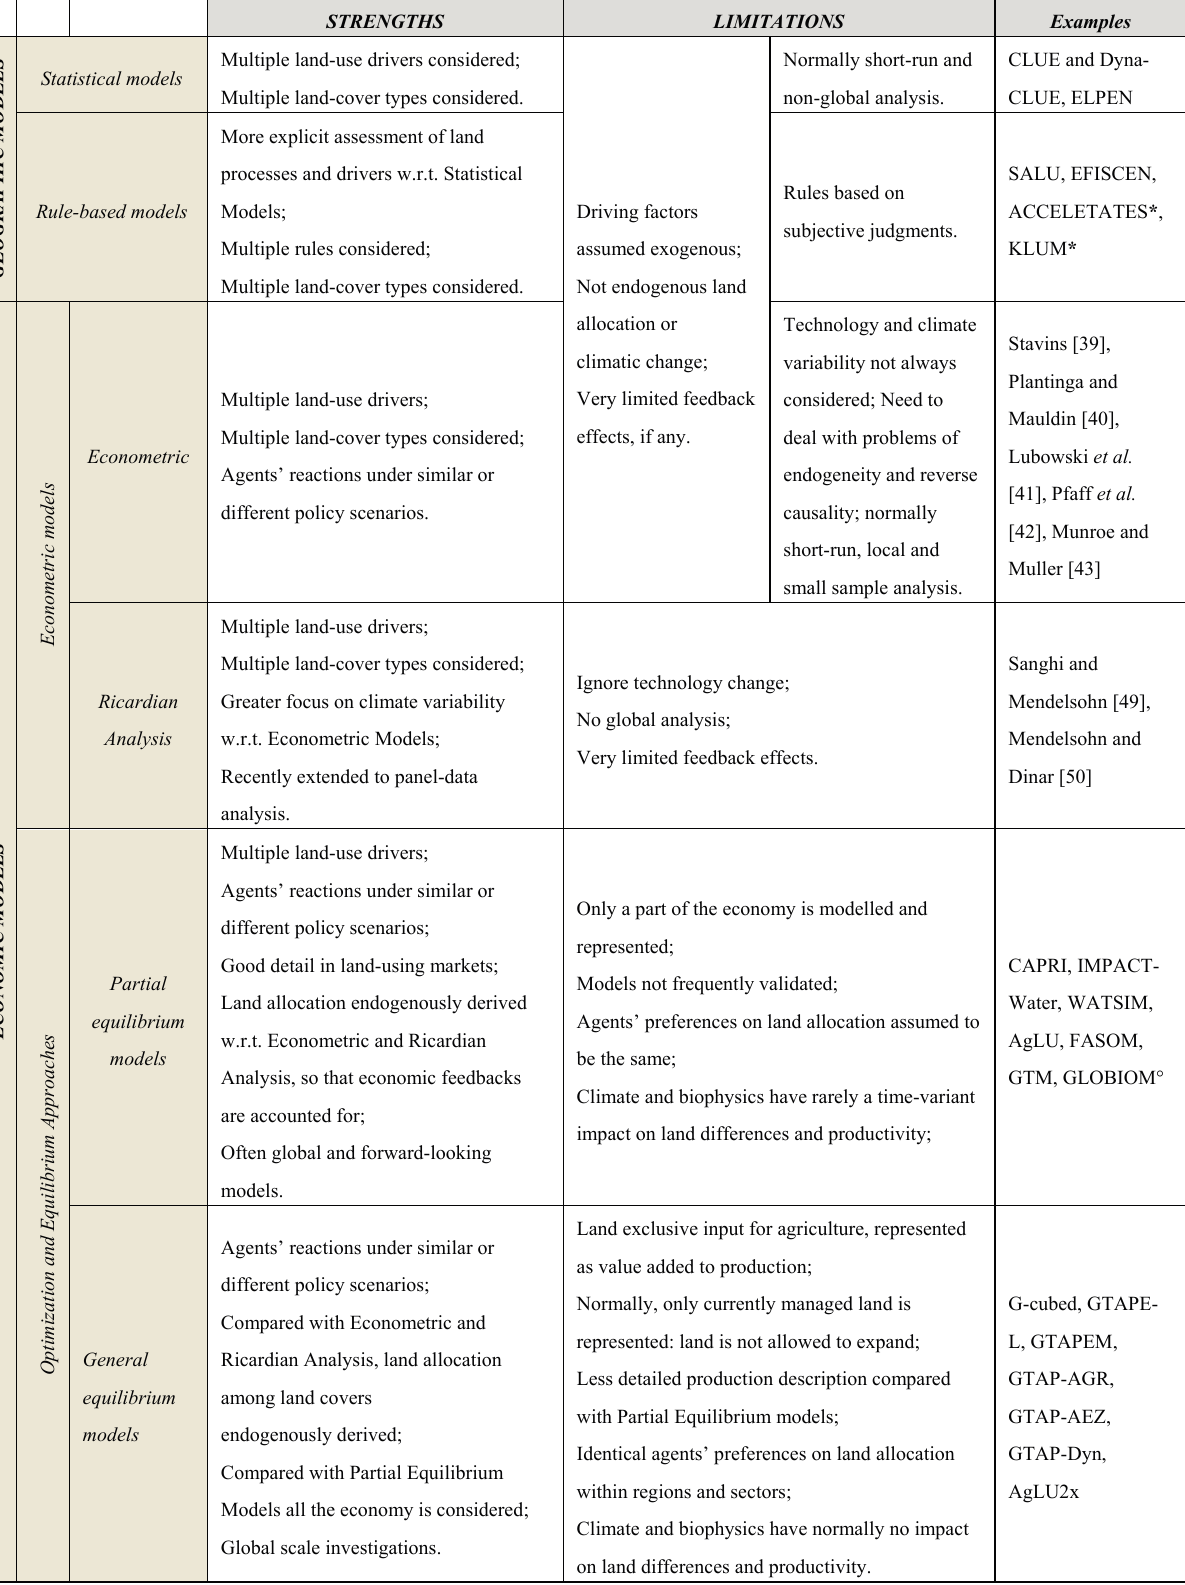
Table 4. Geographic and economic sub-categories: